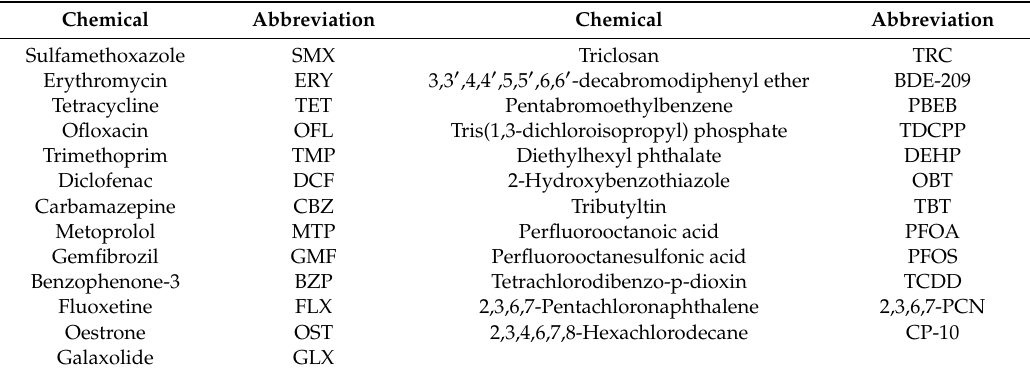
Table 1. Shortlisted chemicals and their